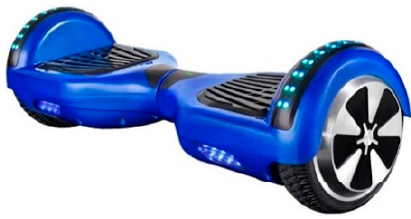
Figure 2. Figure 2. Hoverboard. Figure 2. Hoverboard.